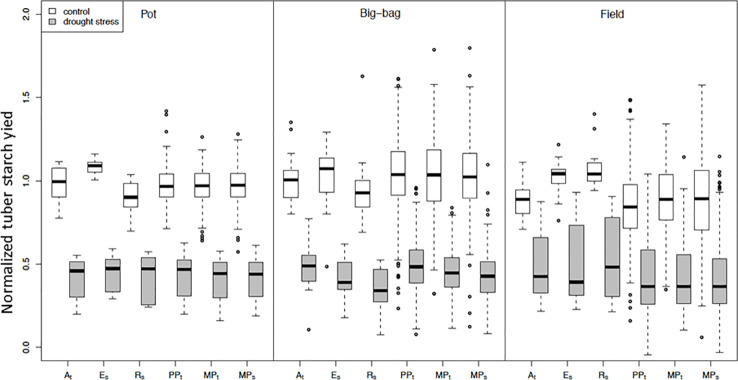
Normalized tuber starch yield of subpopulations PPt, MPt and MPs and parent cultivars At, Es and Rs under control conditions and drought stress. Distribution of normalized mean tuber starch yield under control and stress treatments in pot (P3, P5, P7), big-bag (B2, B4, B6), and field trials (without F1). Starch yield was corrected for spatial effects and normalized to the median of the starch yield of the parent cultivars under control conditions. Result of ANOVA on starch yield in single experiments see
Table 3
.